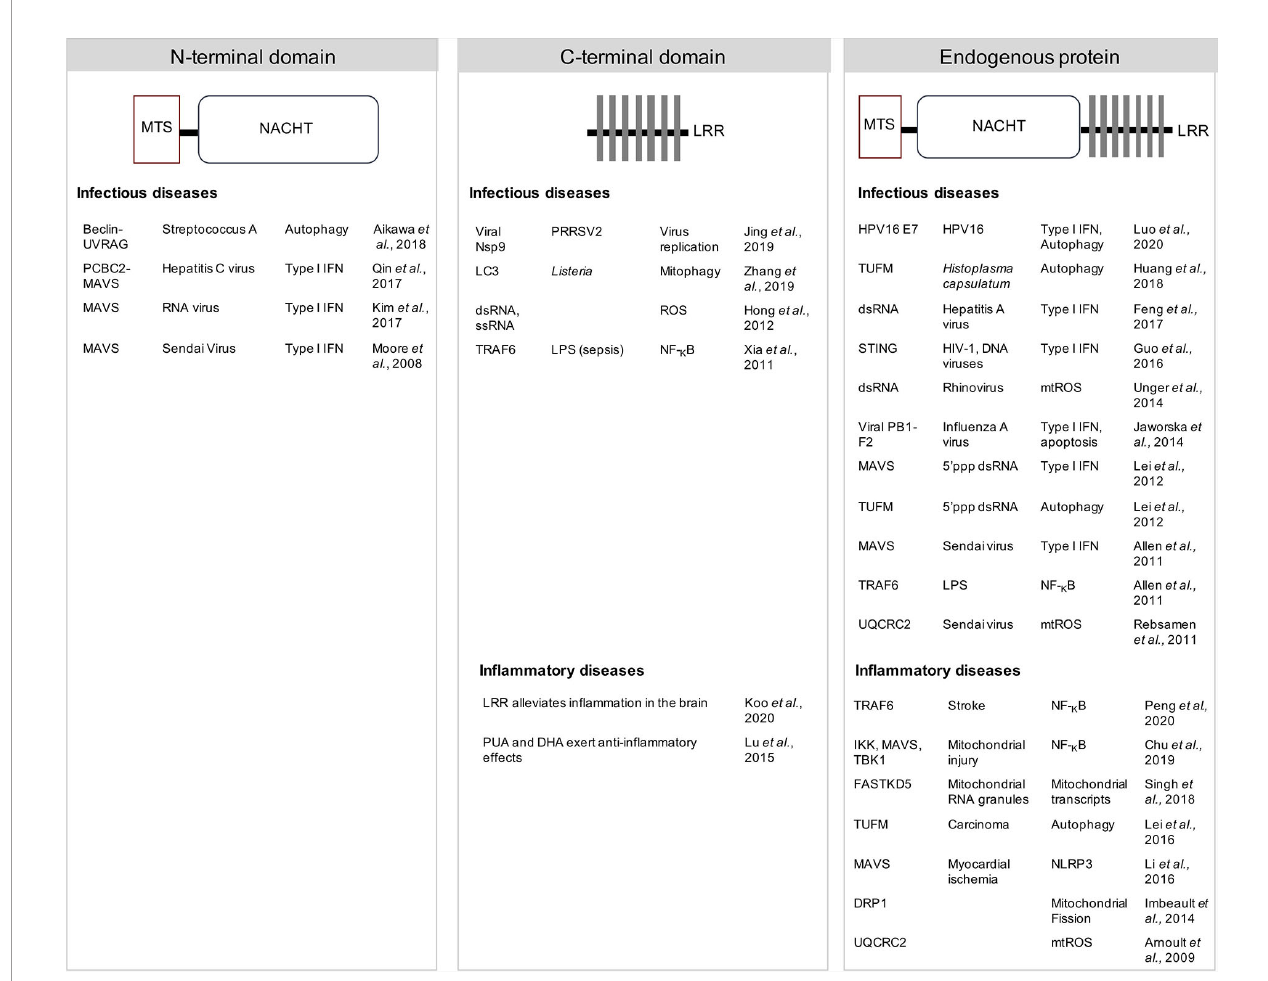
FIGURE 2 | NLRX1 modulates innate immunity and in fl ammation. Multiple mechanisms of action and direct interacting partners are proposed in different experimental models. The N-terminal central nucleotide-binding domain (NACHT) of NLRX1 plays a role in attenuating MAVS-dependent anti-viral signalling by inhibiting the type I interferon (IFN) response against both ssRNA and dsRNA viruses. In addition, the NACHT domain was necessary to inhibit invasion and autophagosome formation upon Streptococcus A infection. Multiple functions are proposed to depend on the C-terminal leucine rich repeat (LRR). LRR was shown to directly bind a viral RNA polymerase Nsp9 of porcine reproductive and respiratory syndrome virus-2 (PRRSV2) to limit virus replication, or to bind LC3 to induce Listeria monocytogenes -dependent mitophagy, or to induce mtROS upon RNA stimulation. The LRR also limited in fl ammation in both infectious and in fl ammatory disease models. Many binding partners have been proposed using the endogenous protein. NLRX1 could play a role in modulating type I IFN signalling, NF- K B pathway, autophagy and several mitochondrial functions. Thus, a consensus regarding the exact mechanism of action of NLRX1 still requires further investigation. DRP1, GTPase dynamin-related protein 1; FASTKD5, FAST kinase domain-containing protein 5; HPV, human papillomavirus; IKK, I k B kinase; LC3, microtubule- associated protein 1A/1B-light chain 3; LPS, lipopolysaccharide; MTS, mitochondrial targeting sequence; MAVS, mitochondrial anti-viral signaling protein; NF- k B, nuclear factor kappa-light-chain-enhancer of activated B cells; NLRP3, NOD-, LRR- and pyrin domain-containing protein 3; Nsp9, a viral non-structural protein 9; PB1-F2, in fl uenza virus protein PB1-F2; PCBC2, poly(rC) binding protein 2; ROS, reactive oxygen species; STING, stimulator of interferon genes; TBK1, TANK- binding kinase 1; TRAF6, TNF receptor-associated factor 6, TUFM, Tu translation elongation factor; UQCRC2, ubiquinol-cytochrome c reductase core protein II; UVRAG, UV irradiation resistance-associated